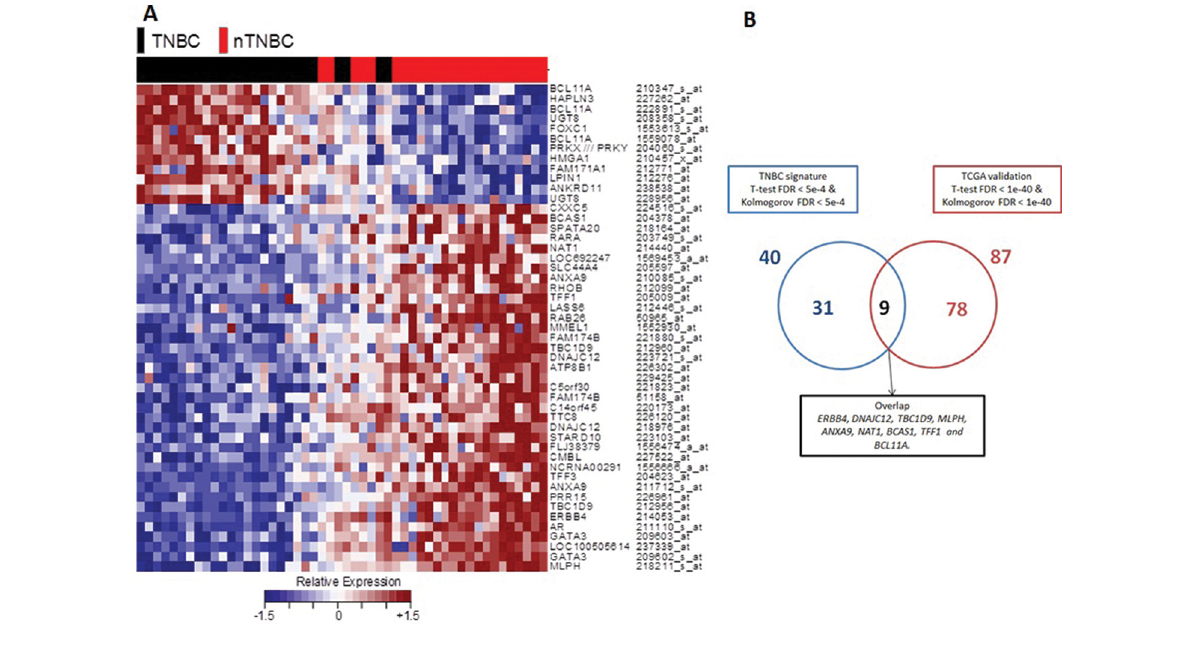
Figure 3. TNBC signature. (A) The heat map shows 49 differentially expressed probes (corresponding to 40 genes) in TNBC versus nTNBC. At the bottom of the figure is a color code that shows expression intensity (Z score). Blue represents low gene expression, red high gene expression. At the top of the figure is a color code for TNBC (black) and nTNBC (red) patients. In the heat map, each column is for a patient and each row is for a single probe. The right side of the heat map shows official symbol gene and probe identification. (B) Venn diagram of TNBC signature and TCGA validation. Blue circle represents 40 genes of our TNBC signature. Red circle represents 87 genes from TCGA data. Overlap of both circles (blue and red) represents nine genes that are present in both sample data using same